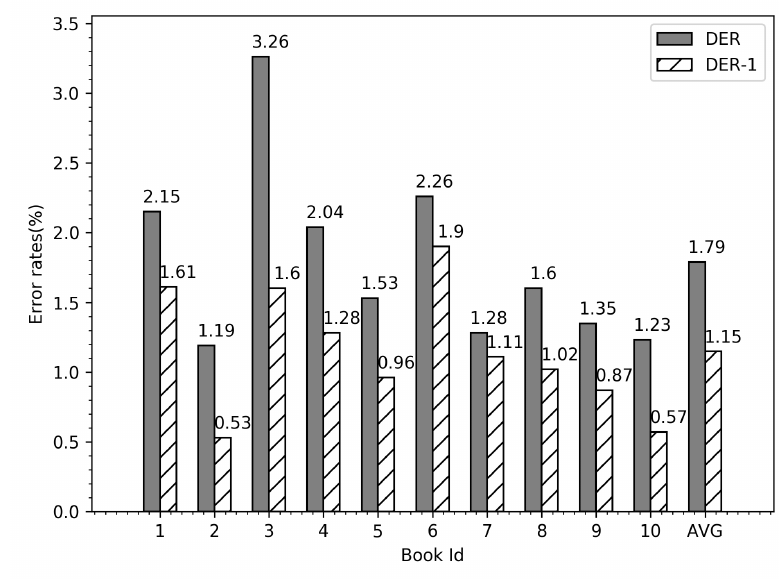
Figure 11. DER and DER-1.